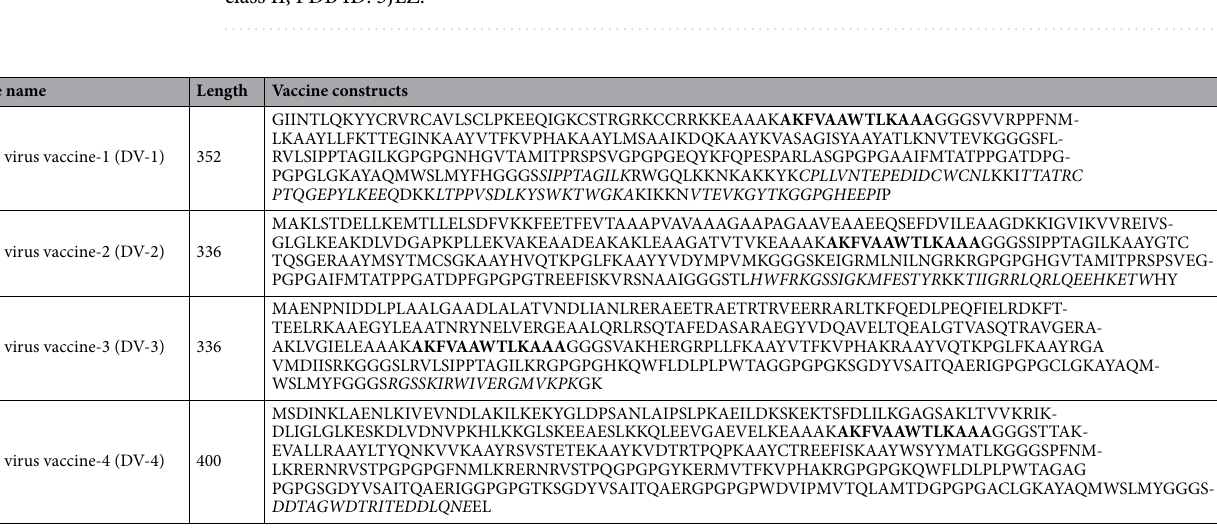
Figure 1. The prepared 3D structures of the Toll-like and Major histocompatibility complex receptors used in this study. ( A ) TLR-2; PDB ID: 2ZX; ( B ) TLR-4; PDB ID: 3FX1; ( C ) MHC class I; PDB ID: 5WJL; and ( D ) MHC class II; PDB ID: 5JLZ.